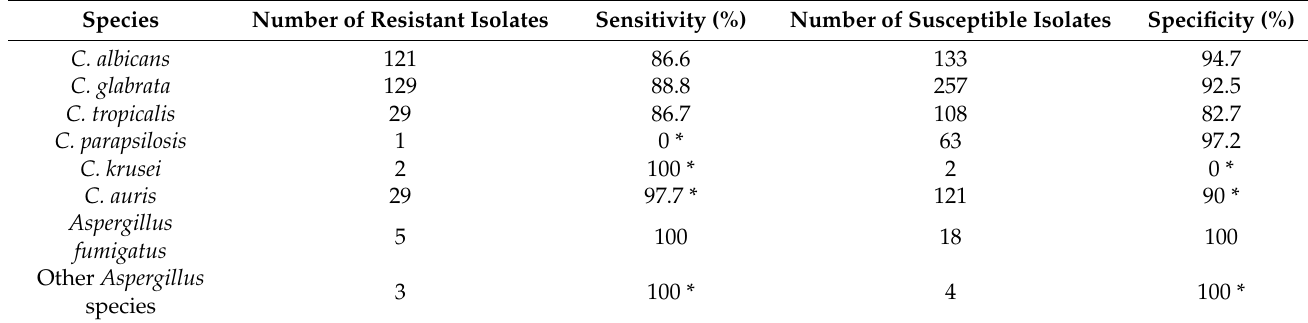
Figure 5. Specificity by the group of the antifungal substance. Table 3. Sensitivity and specificity by species.